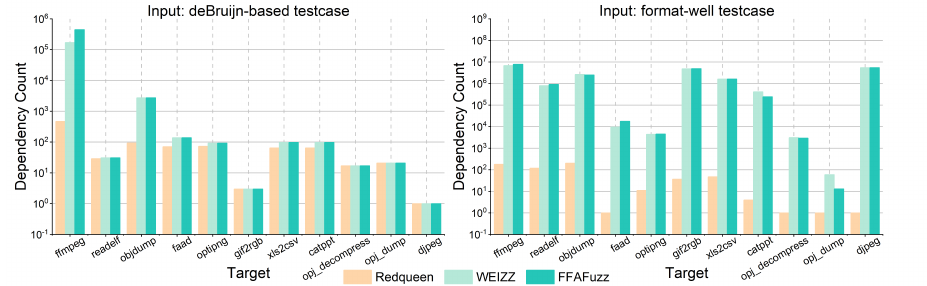
Figure 9. The dependency amounts obtained by dependency recognition for